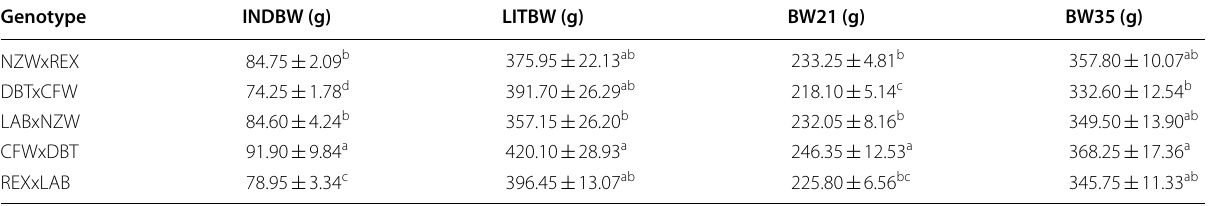
Table 2 Effect of genotype on least-squares means of body weights of crossbred kits